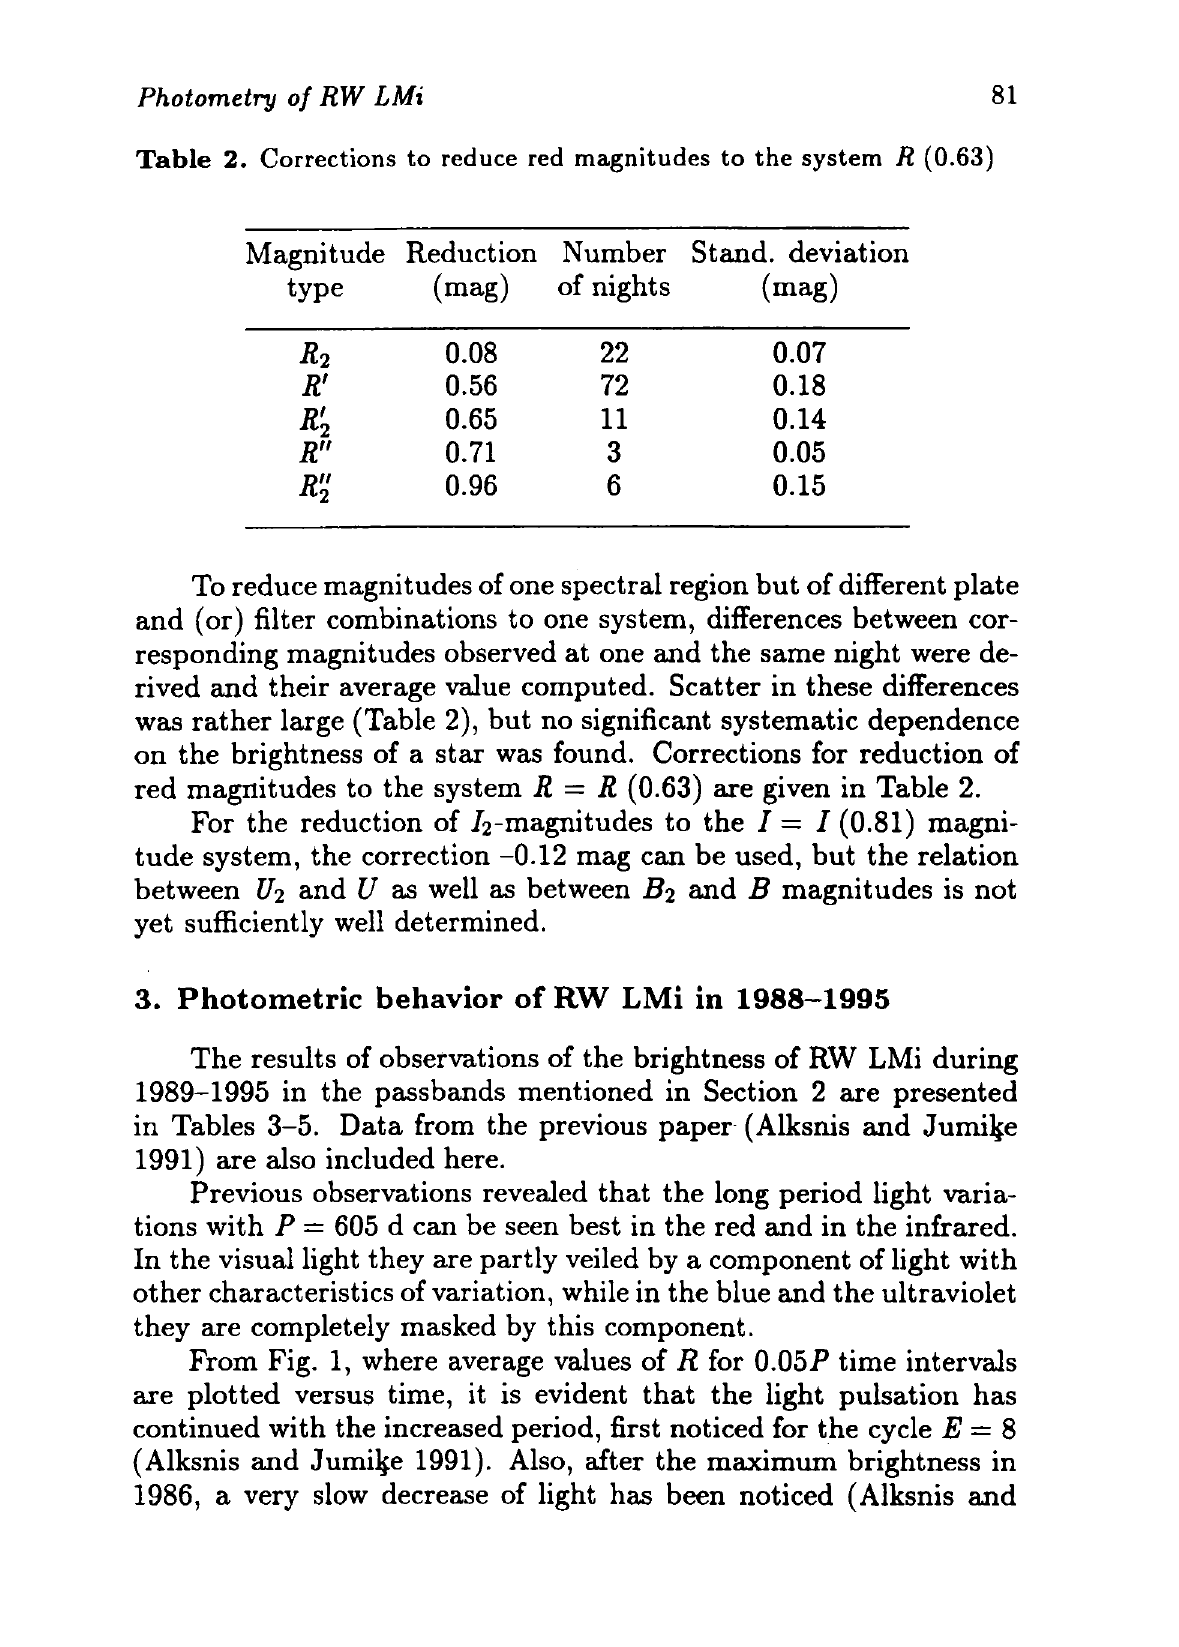
Table 2. Corrections to reduce red magnitudes to the system R